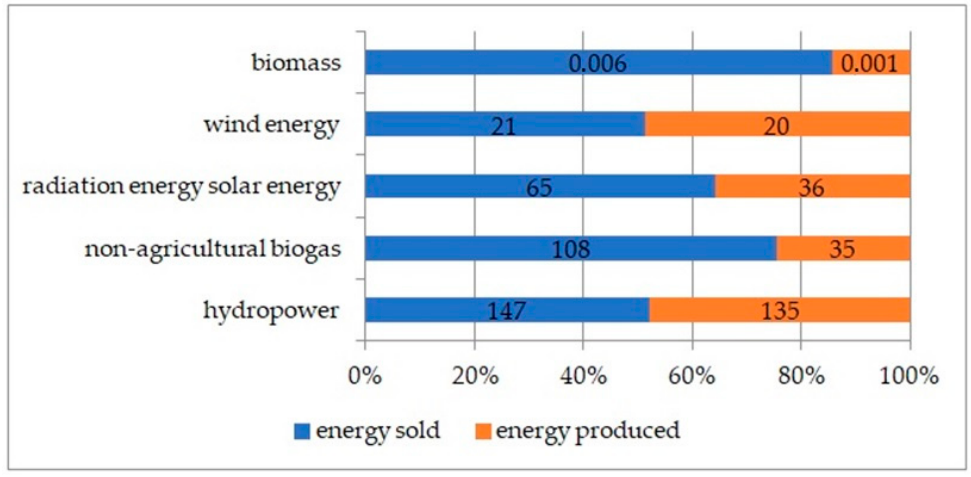
Figure 14. Renewable energy in 2020 (GWh) [59].